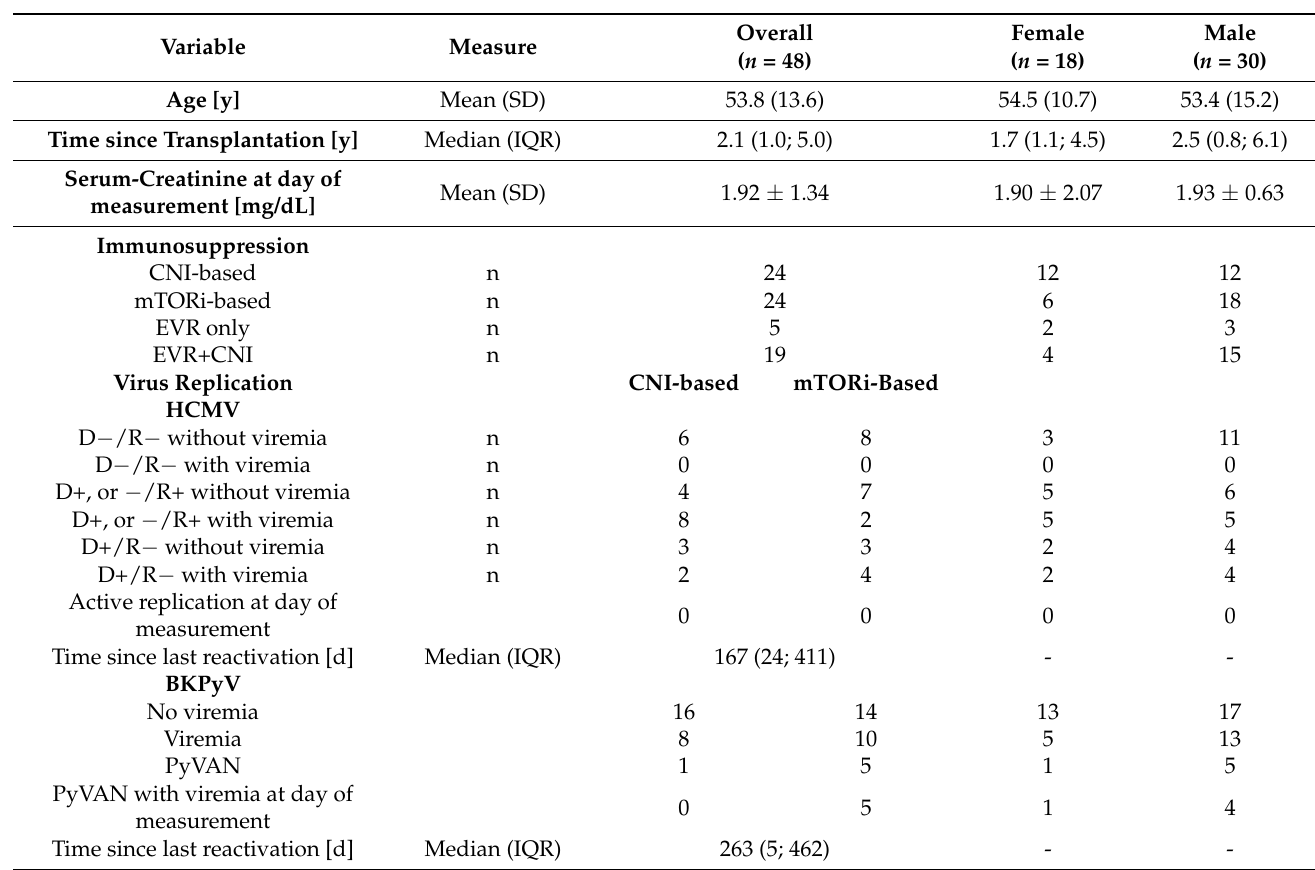
Table 1. Patients’